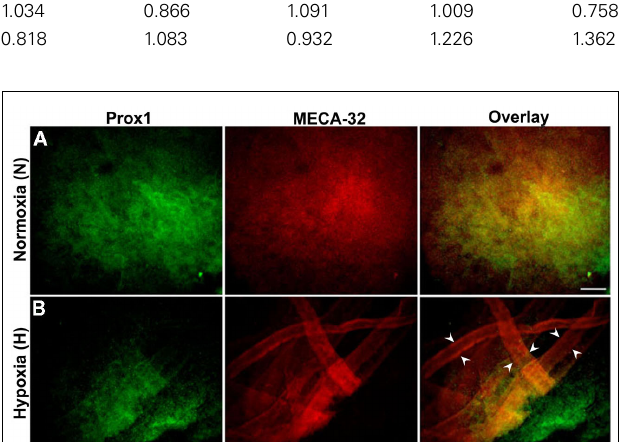
FIGURE 2 | Quantitative-PCR analyses of gene expression of vascular marker (MECA-32) and LEC markers (LYVE1,VEGFR-3, Prox1) across different days of EB development under conditions of normoxia (N) and hypoxia (H). Fold changes are expressed as ratios of N/H. Fold changes > 1.0 indicates that expression of the genes of interest was enhanced under normoxic conditions during all time points. Data represents mean ± SEM, *fold change significantly greater than 1 ( p < 0.05; n = 4).